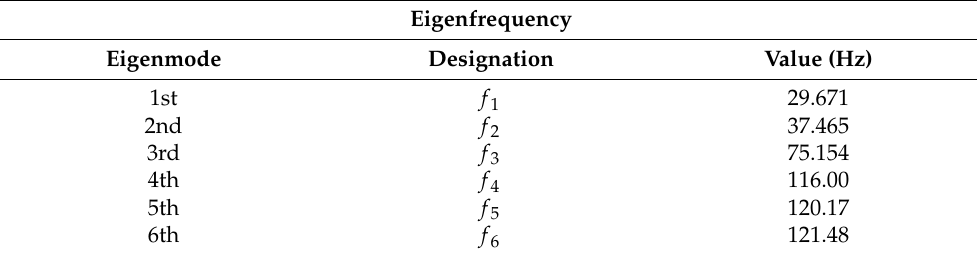
Table 3. Eigenfrequencies of oscillation of the E3-cycle frame, undamped oscillation.